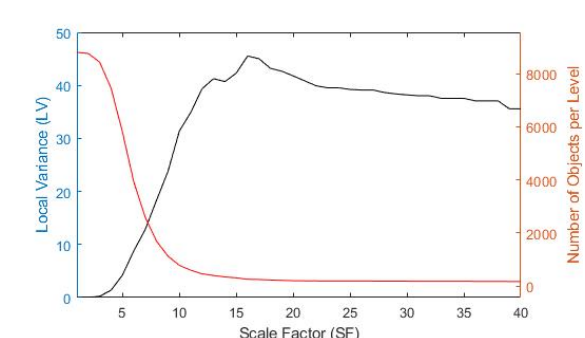
Figure 5. Number of objects generated per hierarchical level (red line) and overall local variance (LV) per hierarchical level (black line)